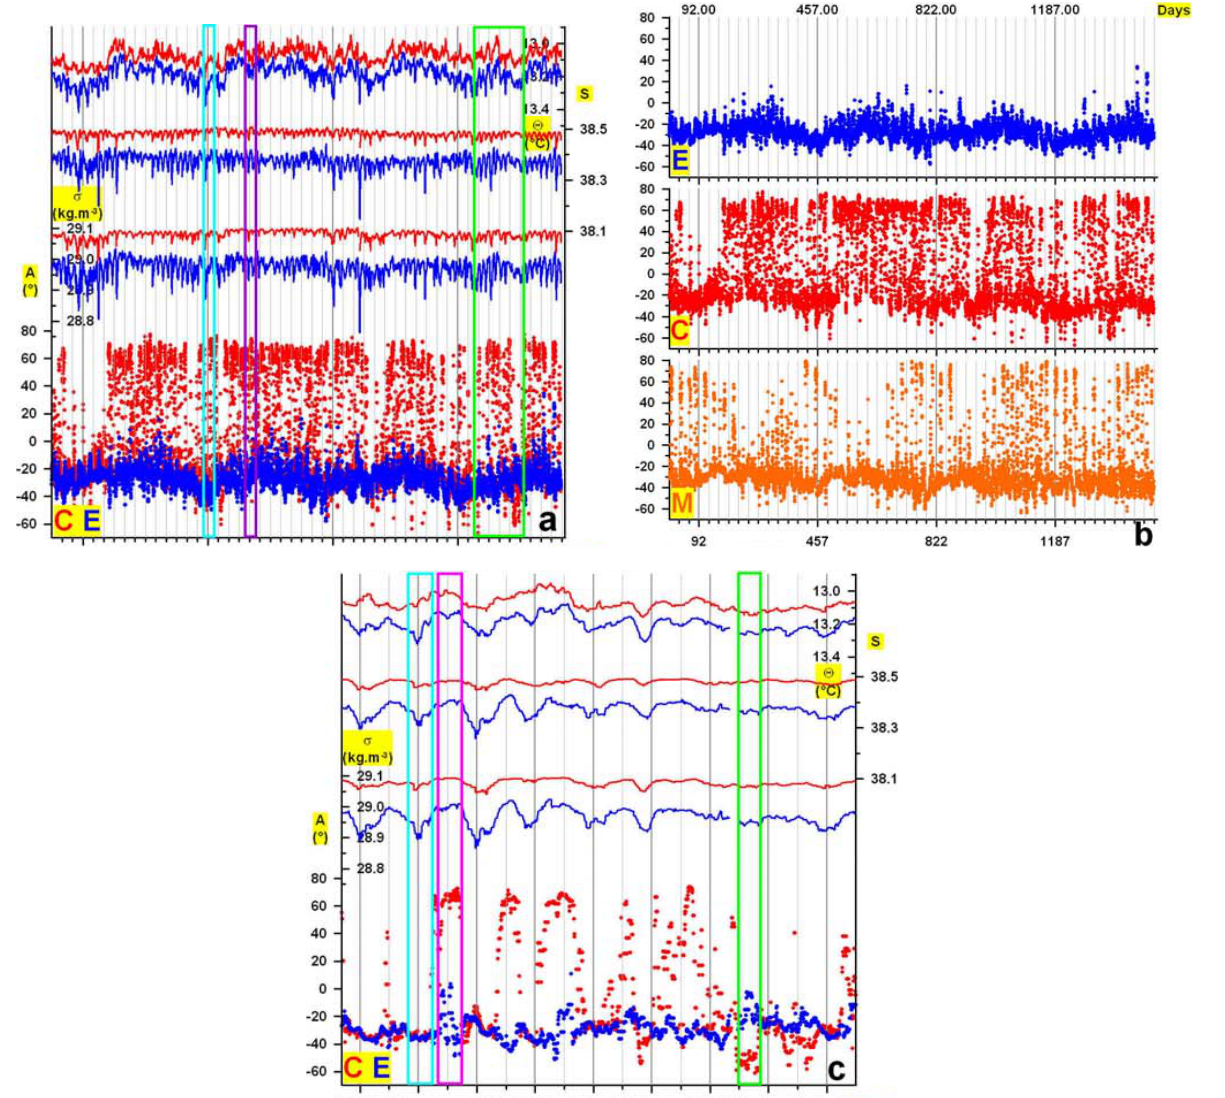
Fig. 3. (a) Time series (25-h median values) at both C (red) and E (blue) during the whole period (d1–d1490); on the time axis, major grid lines (dark grey on d92, ...) are on 1 January and minor grid lines (light grey) are one month apart. Coloured periods correspond to data plotted in Fig. 4b (cyan), Fig. 4c (magenta) and (c) (green). Ticks on the vertical axes indicate the overall ranges for the measured parameters 2 (descending axis), S and σ , as well as the range of interest for the computed slope A of the temporal mixing lines. (b) Computed slope A of the temporal mixing lines at E, C and M. (c) As for (a) during the period specified in green in (a) (d1250–d1380); on the time axis, major grid lines (dark grey) indicate spring tide, minor grid lines (light grey) indicate neap tide, both being plotted 14.76 days apart. Coloured periods correspond to data plotted in Fig. 4d (cyan), Fig. 4e (magenta) and Fig. 4f